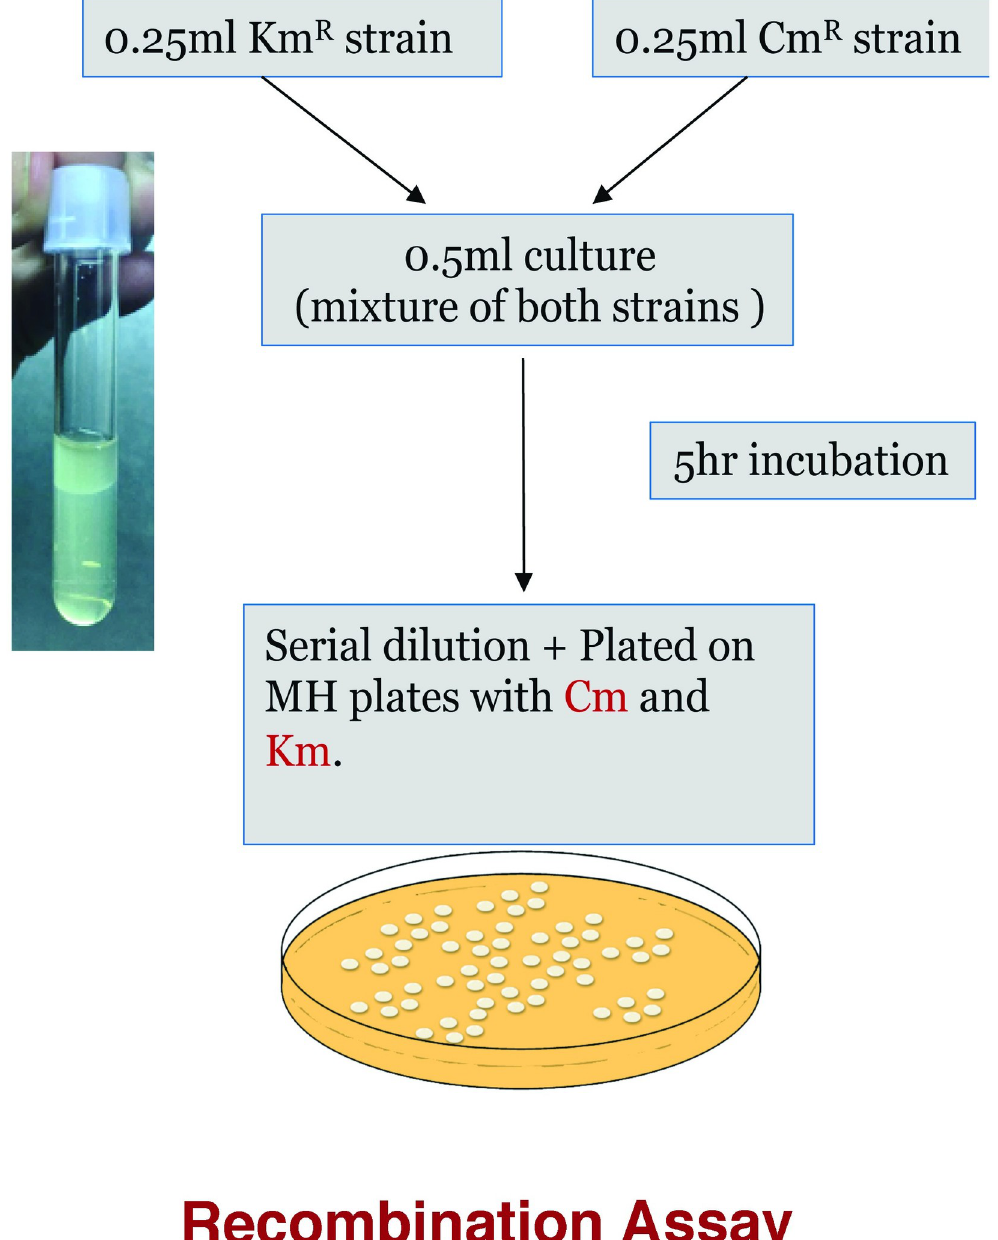
Fig 1. Diagram showing the method used to perform the recombination